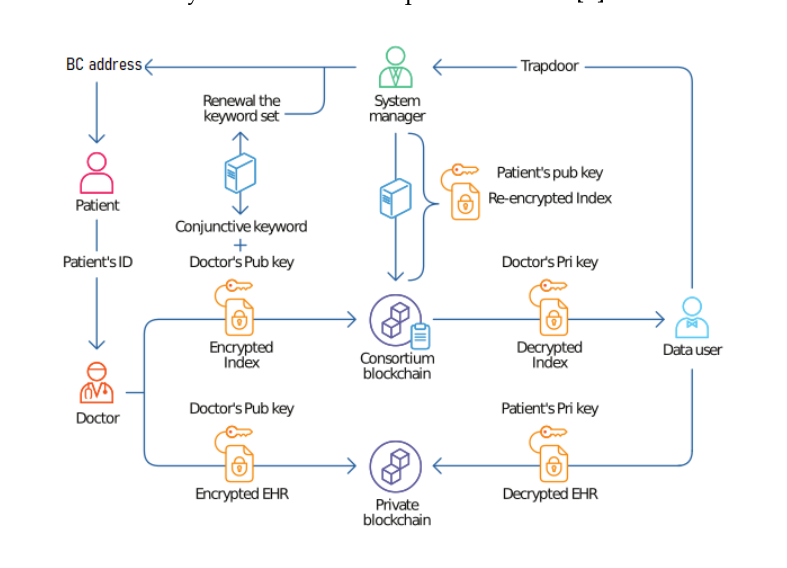
Figure 3. Overview of the proposed protocol.